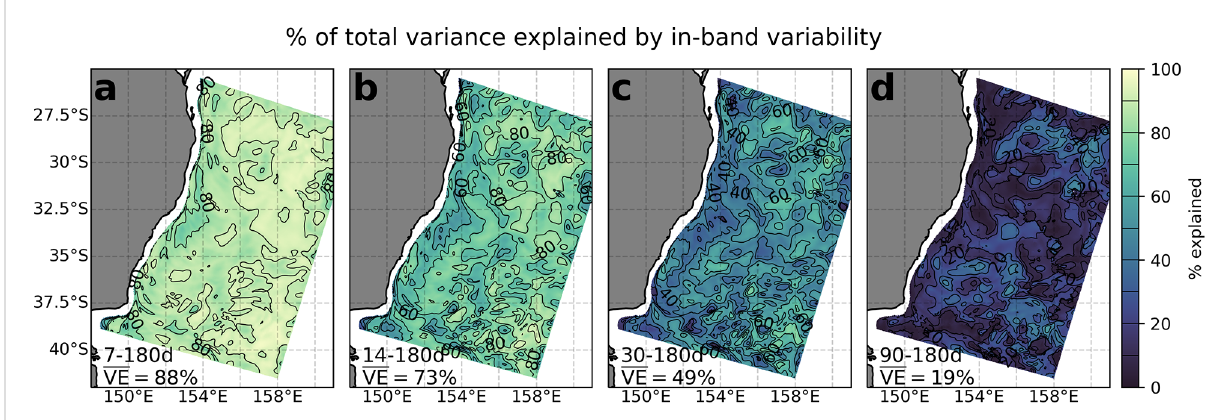
FIGURE 4 Singular spectrum analysis is used to quantify the percentage of the total variance in EKE at 500 m explained in four selected time bands. The variance with a period greater than (A) 7 days, (B) 14 days, (C) 30 days and (D) 90 days, and less than 180 days, is expressed as a fraction of the total variance. A high value indicates that a large amount of the full spectrum of variability at that location has a period within the indicated time band. Annotations in each plot show the band over which variance is being explained, and the spatial mean of the in-band variance explained. The contour interval is